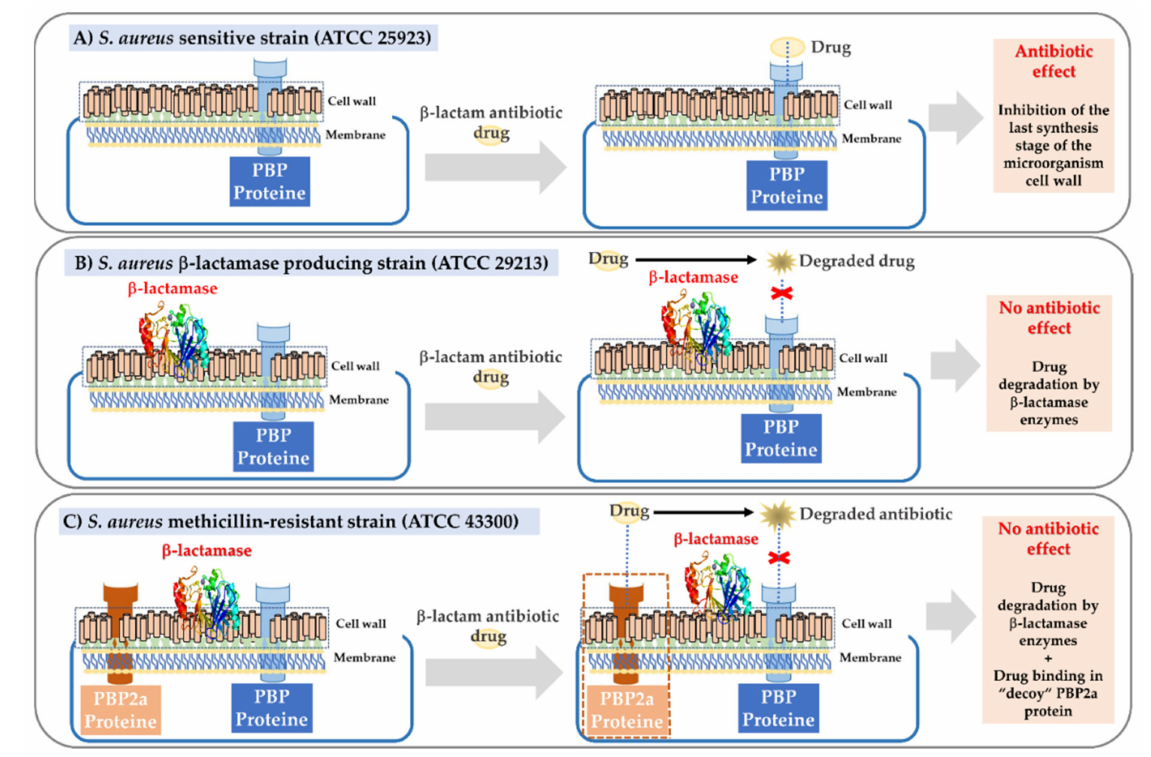
Figure 1. Scheme of the pharmacological mechanisms of β -lactam drugs on S. aureus strains with different degrees of resistance. ( A ) Sensitive strain. ( B ) β -lactamase producing strain. ( C ) Methicillin-resistant strain with a dual mechanism ( β -lactamase and PBP2a “decoy” protein production).